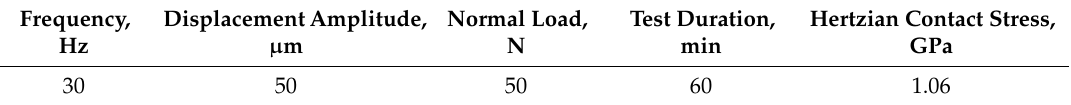
Table 4. Fretting wear test